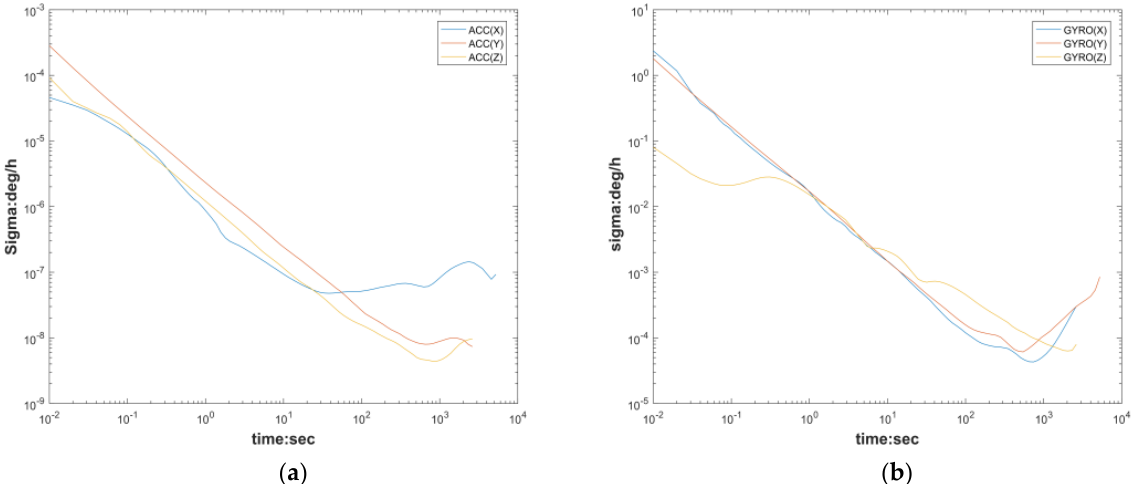
Figure 6. Allen variogram for accelerometer (MEMS0) and gyroscope: ( a ) Accelerometer; ( b ) gyro- scope. Table 2. Allen parameters for the accelerometer (MEMS0) and gyroscope.